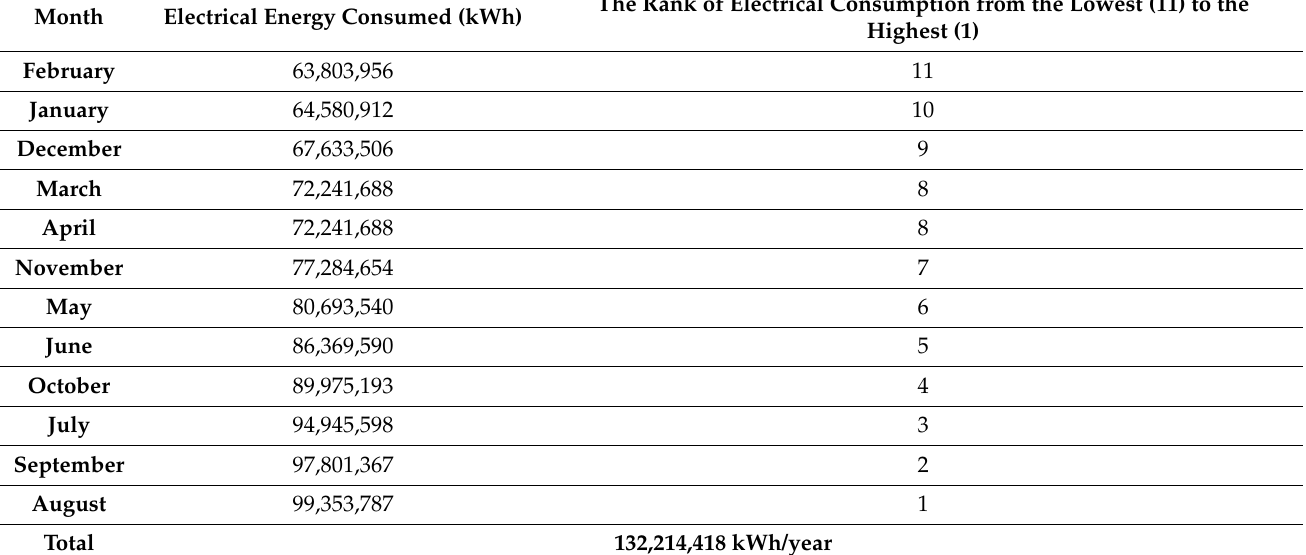
Table A3. Consumption of Electrical Energy for Mafraq Governorate During